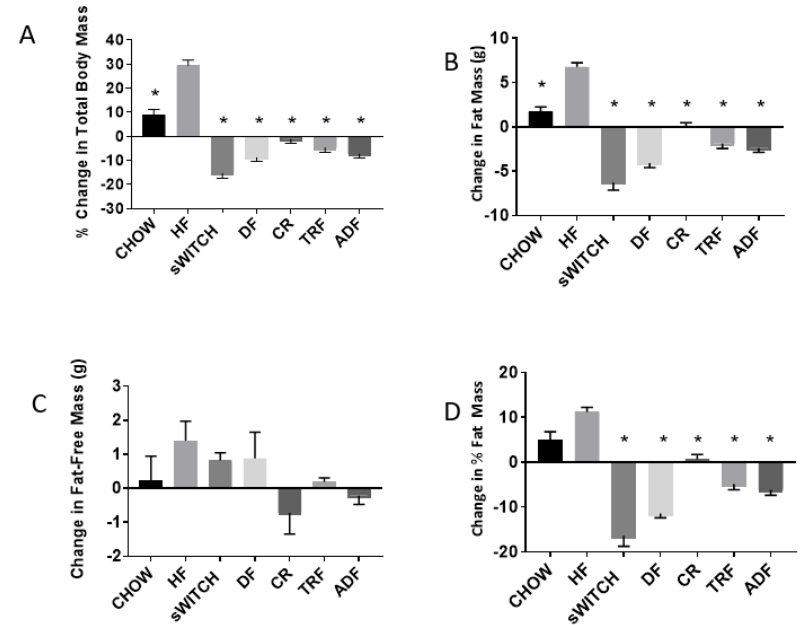
Figure 2. Percent change in total body mass ( A ), fat mass ( B ), fat-free mass ( C ), and percent fat mass ( D ) of male C57BL/6 mice assigned to different dietary protocols for eight weeks. Values are changed post-intervention as compared to pre-intervention. Values are mean ± SEM, n = 7–9 mice per group, In ( A ), * indicates a group effect for change in body mass: HF different from all groups ( p < 0.001); in ( B ), * indicates a group effect for change in FM: HF different from all groups ( p < 0.001); in ( C ), no group effect was observed ( p > 0.050); and in ( D ), * indicates a group effect for change in % FM: HF different from sCHOW, DF, CR, TRF, and ADF ( p < 0.001).